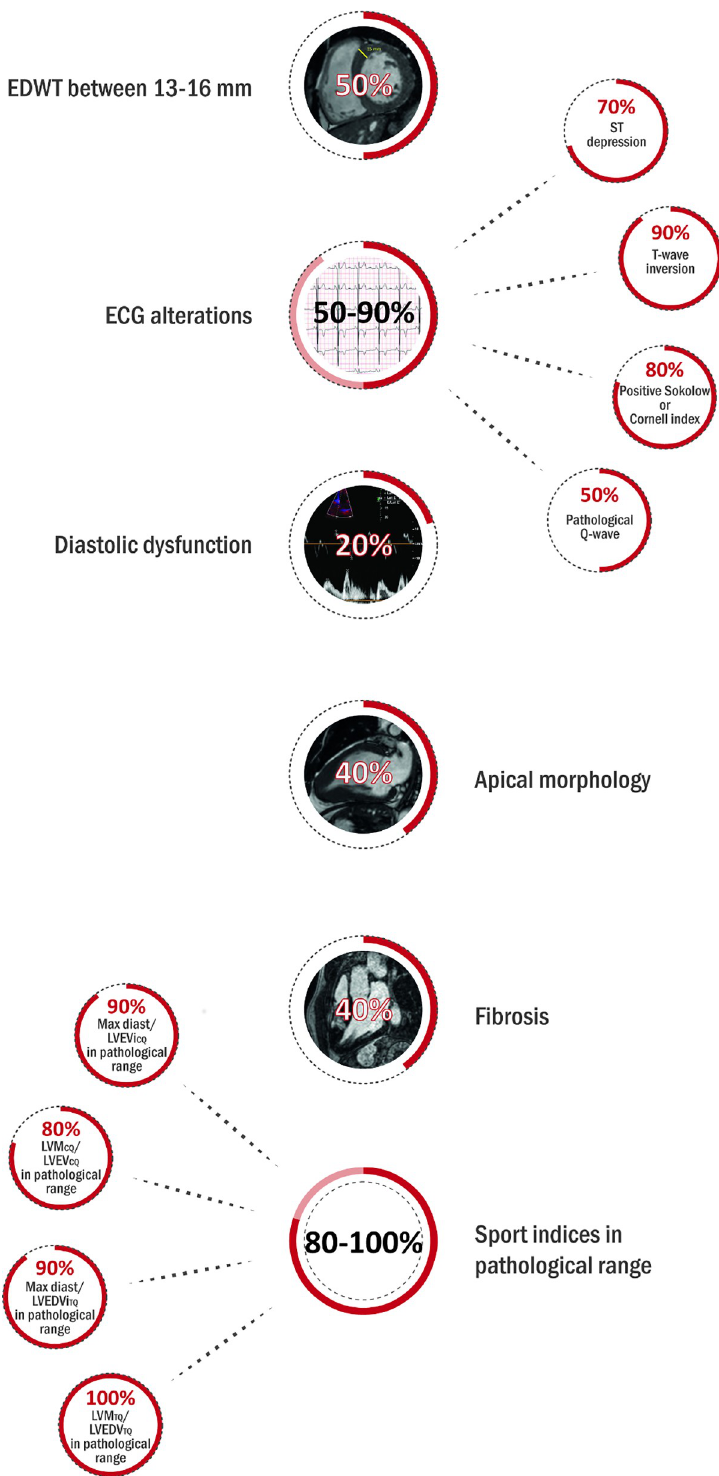
Fig 2. The clinical characteristics of athletes with HCM including pathological ECG findings, diastolic dysfunction evaluated using echocardiography and EDWT, morphology, fibrosis and sport indices evaluated using